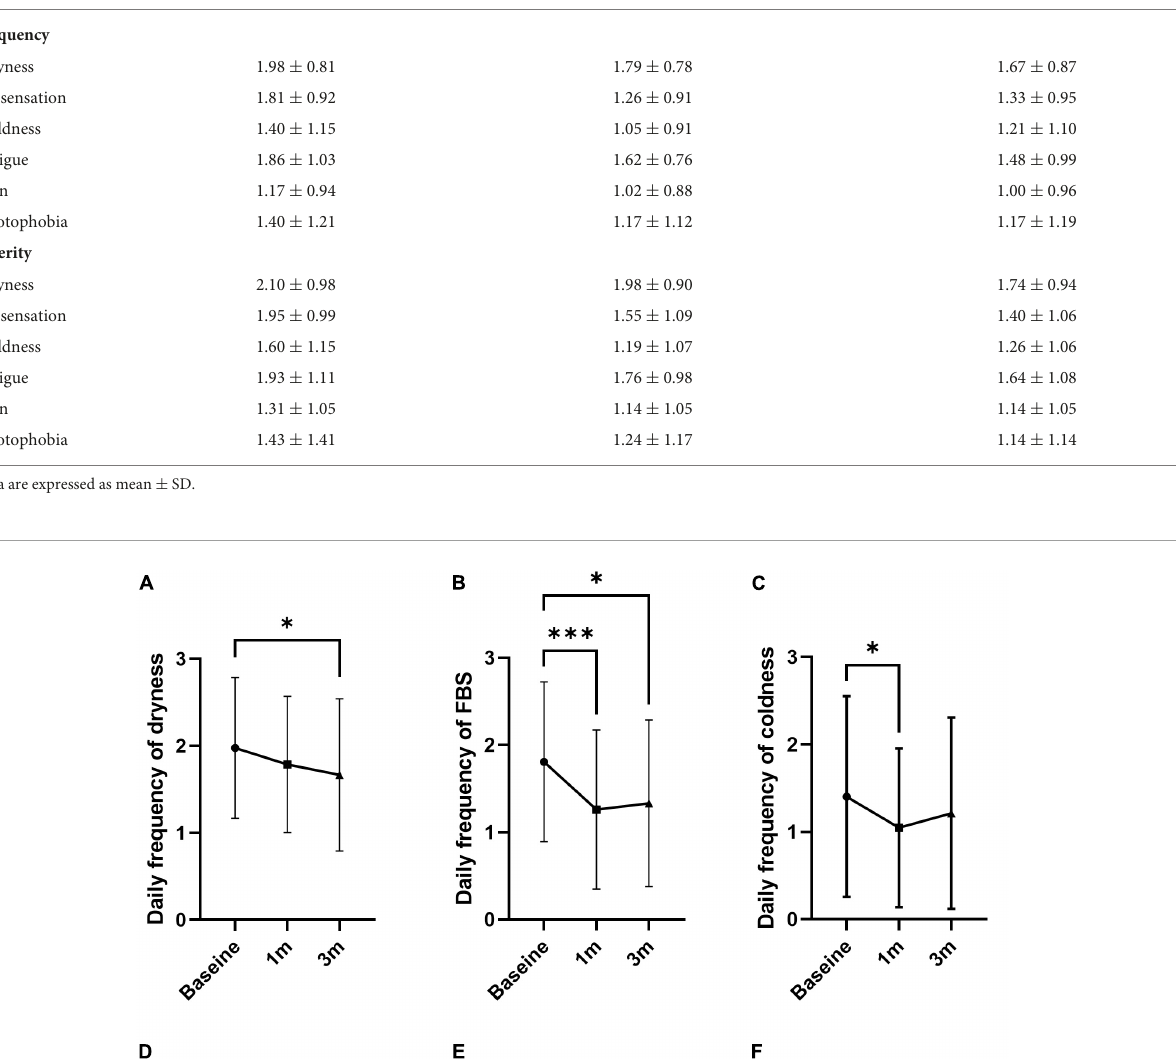
TABLE 2 Changes of frequency and severity of each symptom before and after taking oral MVG. Before taking oral MVG One month after oral MVG Three months after oral MVG